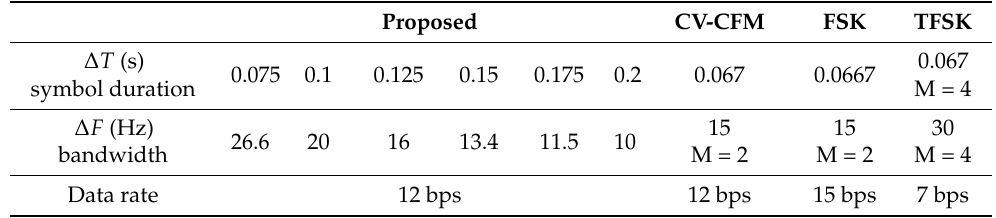
Table 2. Modulation parameters and data